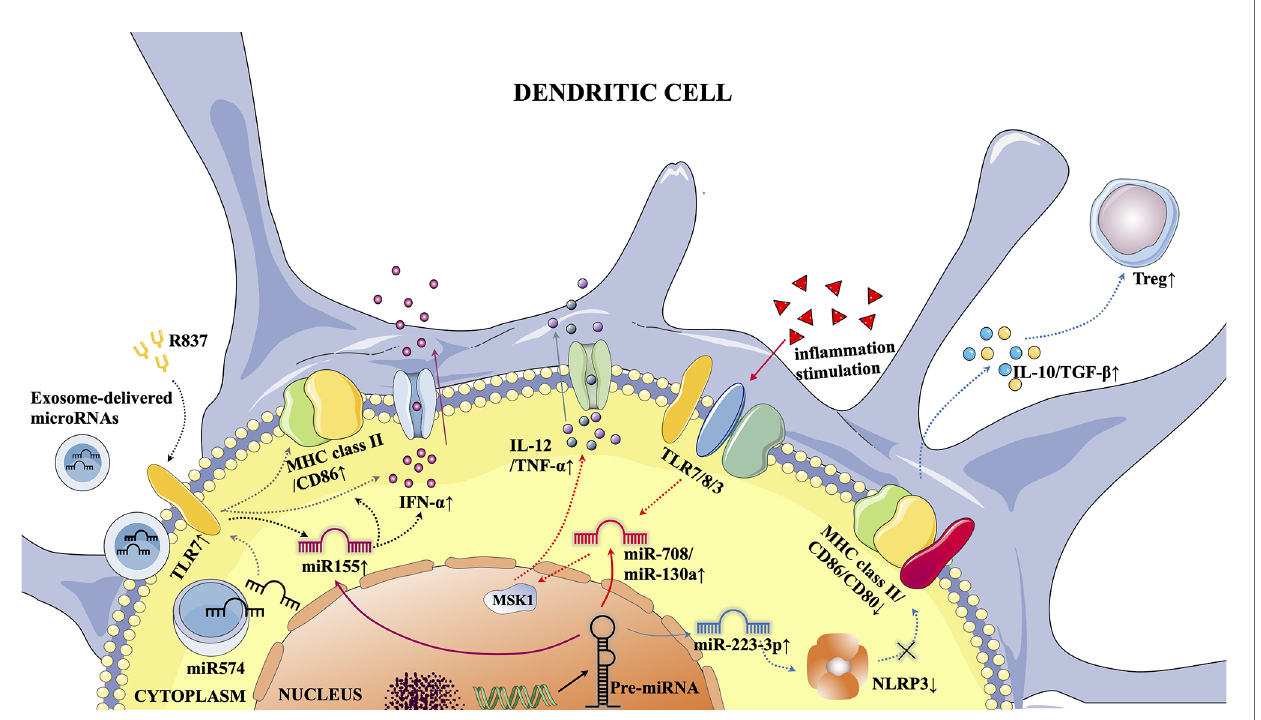
FIGURE 1 | Typical microRNA-mediated pathways in DCs. 1) Activation of TLR7 by the TLR7 agonist R837 resulted in increased miR155 expression, which in turn promoted pDC maturation (elevated MHC class II/CD86 expression) and increased IFN- a secretion. 2) Under the stimulation of extraneous in fl ammatory factors, TLR7/8/3 was activated, which increased the expression of miR-708/miR-130a, leading to the inhibition of MSK1 and promoting the secretion of IL-12/TNF- a in cDCs. 3) The increased expression of miR-223-3p was followed by inhibition of NLRP3 in fl ammocytes, thereby promoting the DC tolerance phenotype (decreased EXPRESSION of MHC Class II/CD86/CD80), leading to increased secretion of IL-10/TGF- b and promoting Treg proliferation. 4) Activation of TLR7 by exosome- derived microRNAs through cell membranes can promote pDC maturation and increase IFN- a